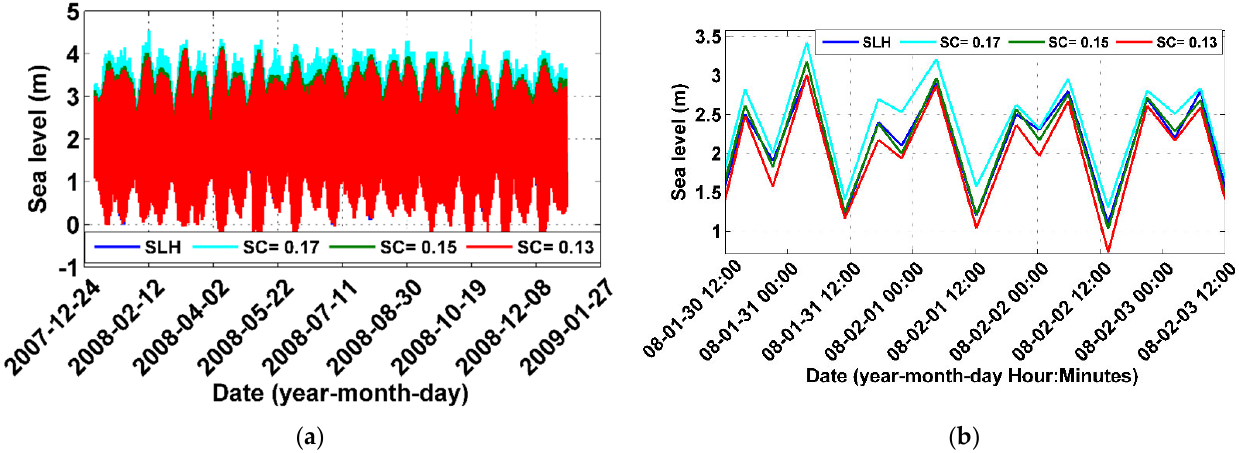
Figure 12. ( a ) Performances of Smagorinsky coefficients (SCs) of 0.13, 0.15, and 0.17 at Rajaei control station and their effects on SLH; ( b ) separated portion of (a) to illustrate more details. Regarding tidal components, the TM-IR01 model was used to calculate a tidal potential for MIKE 21. The results of the TM-IR01 model have already been validated with